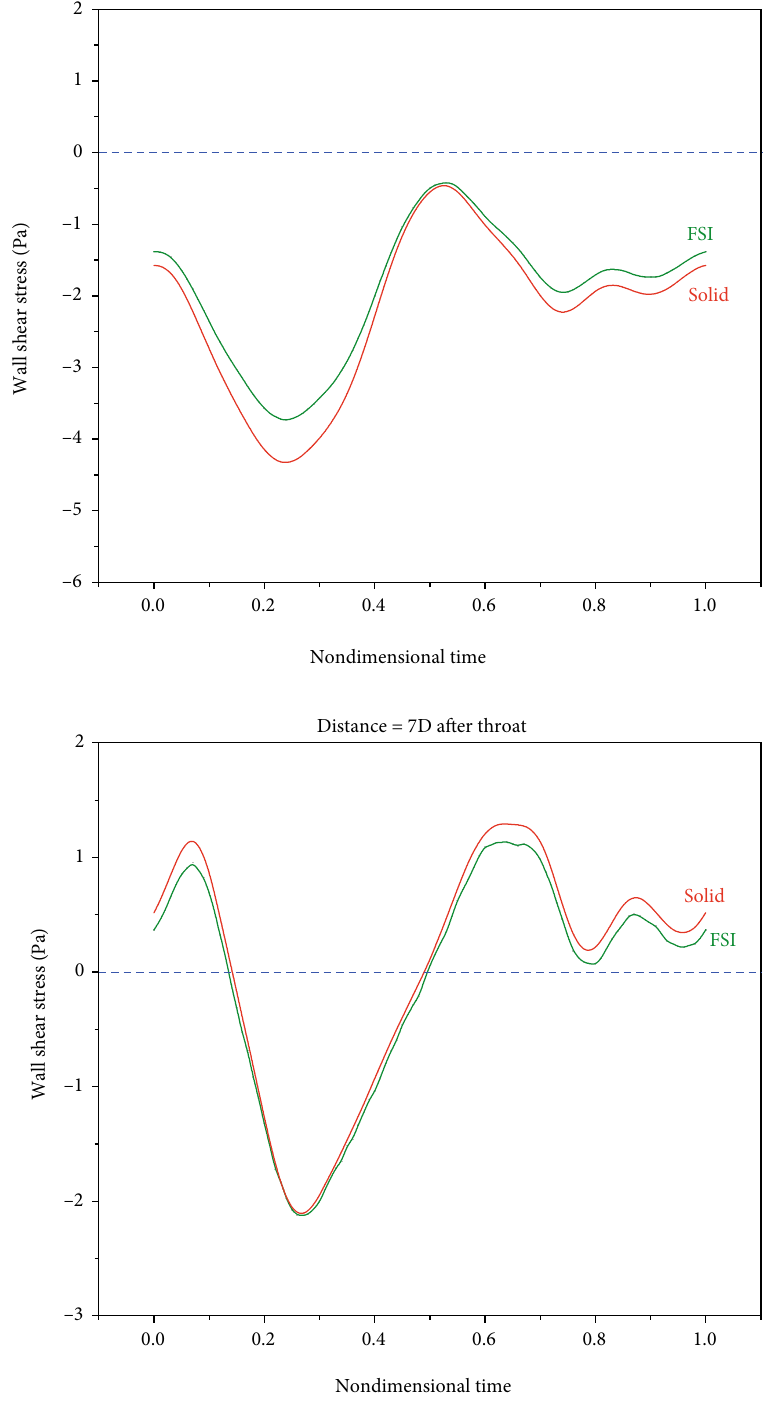
Figure 12: Comparing the WSS of the rigid and elastic walls in simple